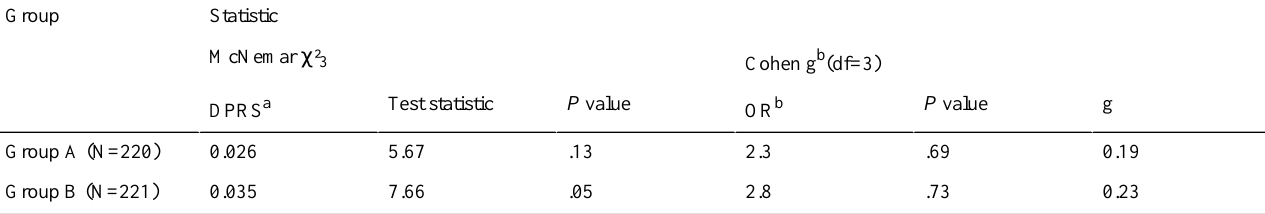
Table 11. McNemar chi-square, Cohen g, and odds ratio (OR): assessment 2 vs assessment 3.